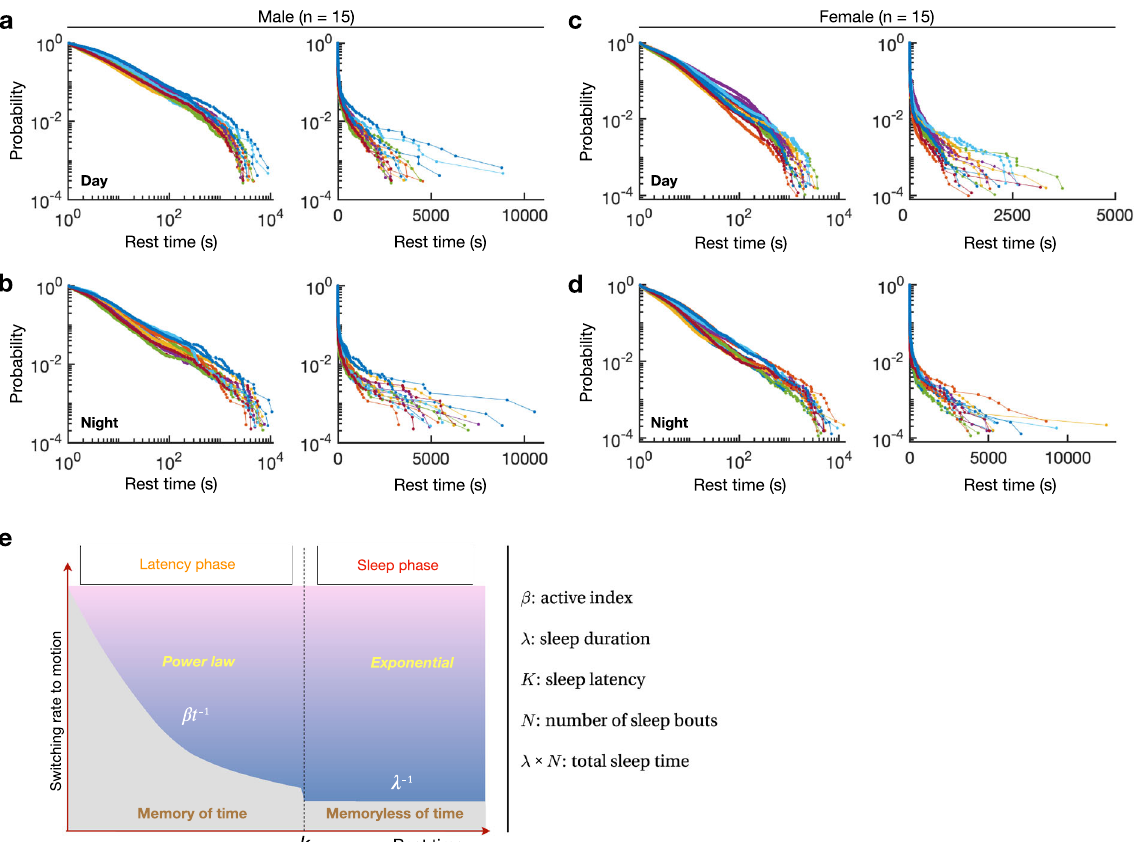
Fig. 2 Quantitative sleep pattern de fi nition based on the probability distribution of rest-bout duration. a – b Probability of rest time of male fl ies in light and dark phases, respectively. c – d Probability of rest time of female fl ies in light and dark phases, respectively. For both the males and females, 15 examples are shown. Graphs on the left panels of ( a – d ) use logarithmic scales on both the horizontal and vertical axes, and on the right panels only use logarithmic scale on the vertical. e Schematic of the two phases of sleep behavior in the fl y. Power law decay and exponential decay is separated by the sleep latency ( K ). Five sleep parameters (shown on the right) can be extracted from the sleep pattern to quantitatively analyze the sleep behavior of each individual fl